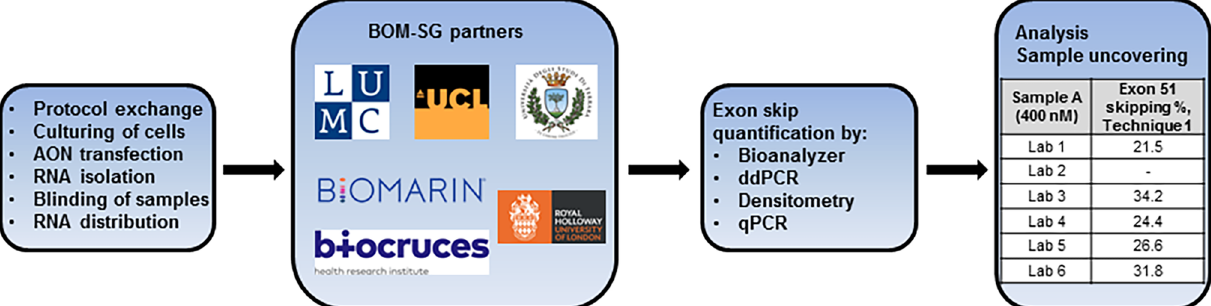
Fig 1. Flow diagram of the study design. Two transfection experiments and exon skipping quantification were performed. AON = antisense oligonucleotide, BOM-SG = biochemical outcome measures group, ddPCR = digital droplet PCR and qPCR = quantitative real-time PCR.